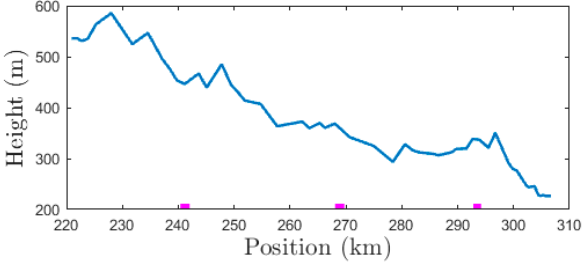
Figure 4. Height profile of the Calatayud–Zaragoza section. Neutral zones are represented in magenta.